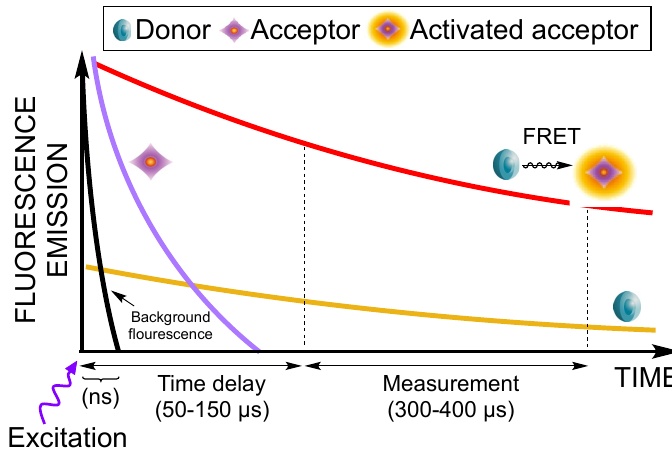
Figure 1. Principle of time-resolved detection. After an initial excitation pulse, a delay of 50–150 µs is introduced. Background fluorescence from, e.g., media, ligands and/or buffer will fade within nanoseconds (ns). When starting the measurement after the time delay only the long emitting donor fluorophore and the activated acceptor will emit